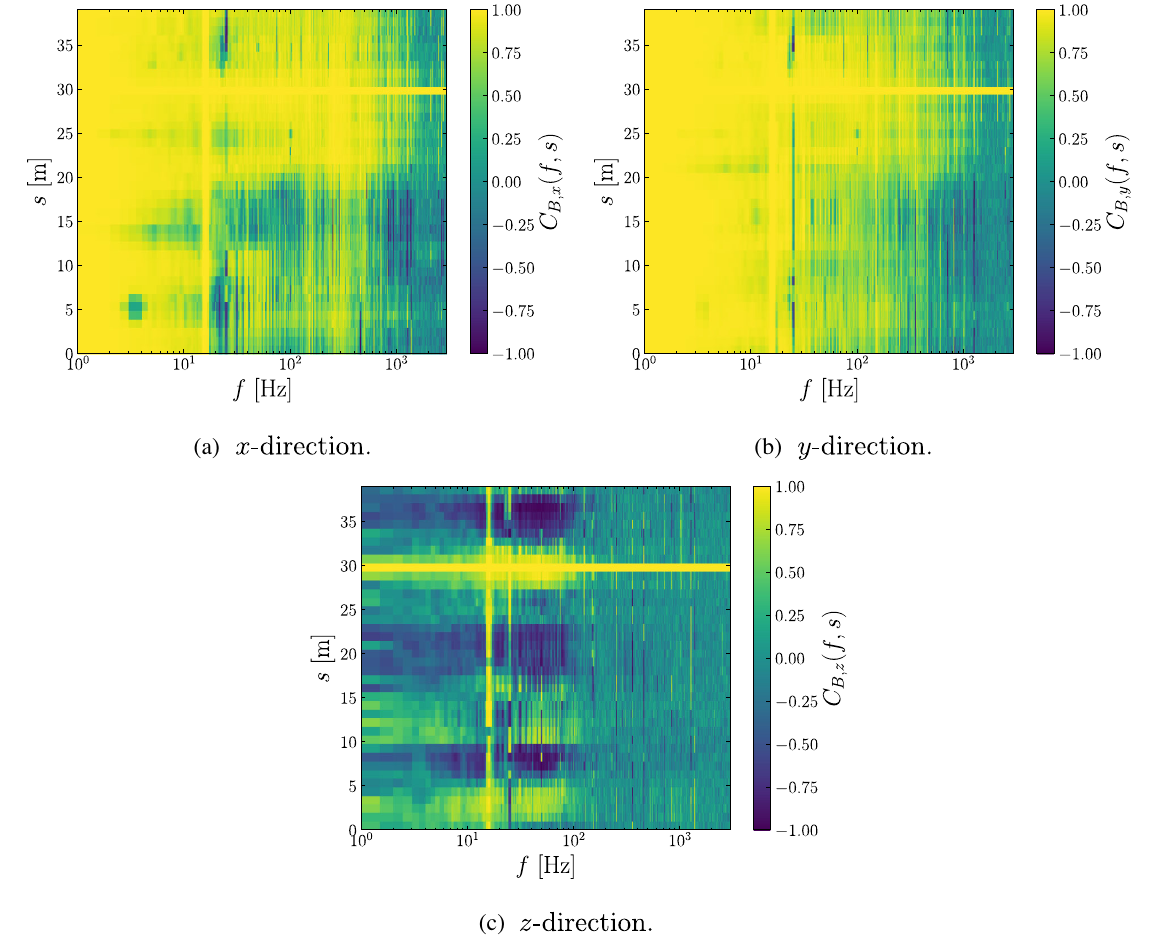
FIG. 6. Correlation of the magnetic field with respect to s ¼ 30 m (right-hand side scale) in the x , y and z -direction, C B;x ð f; s Þ , C f; s Þ and C f; s Þ respectively, vs location s (left-hand side scale) and frequency f C;y ð B;z ð